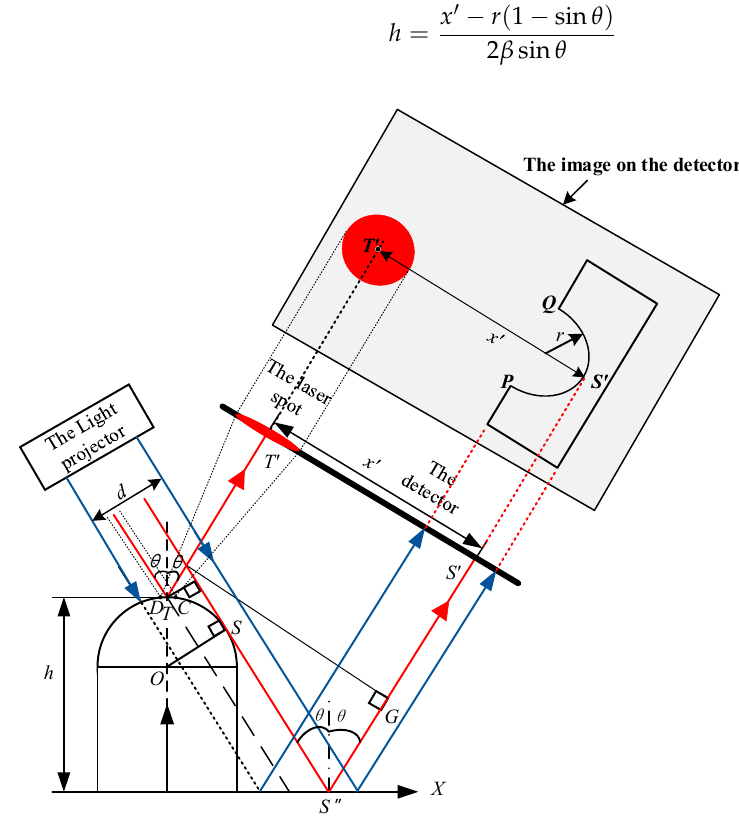
Figure 4. The measuring principle of the height of the